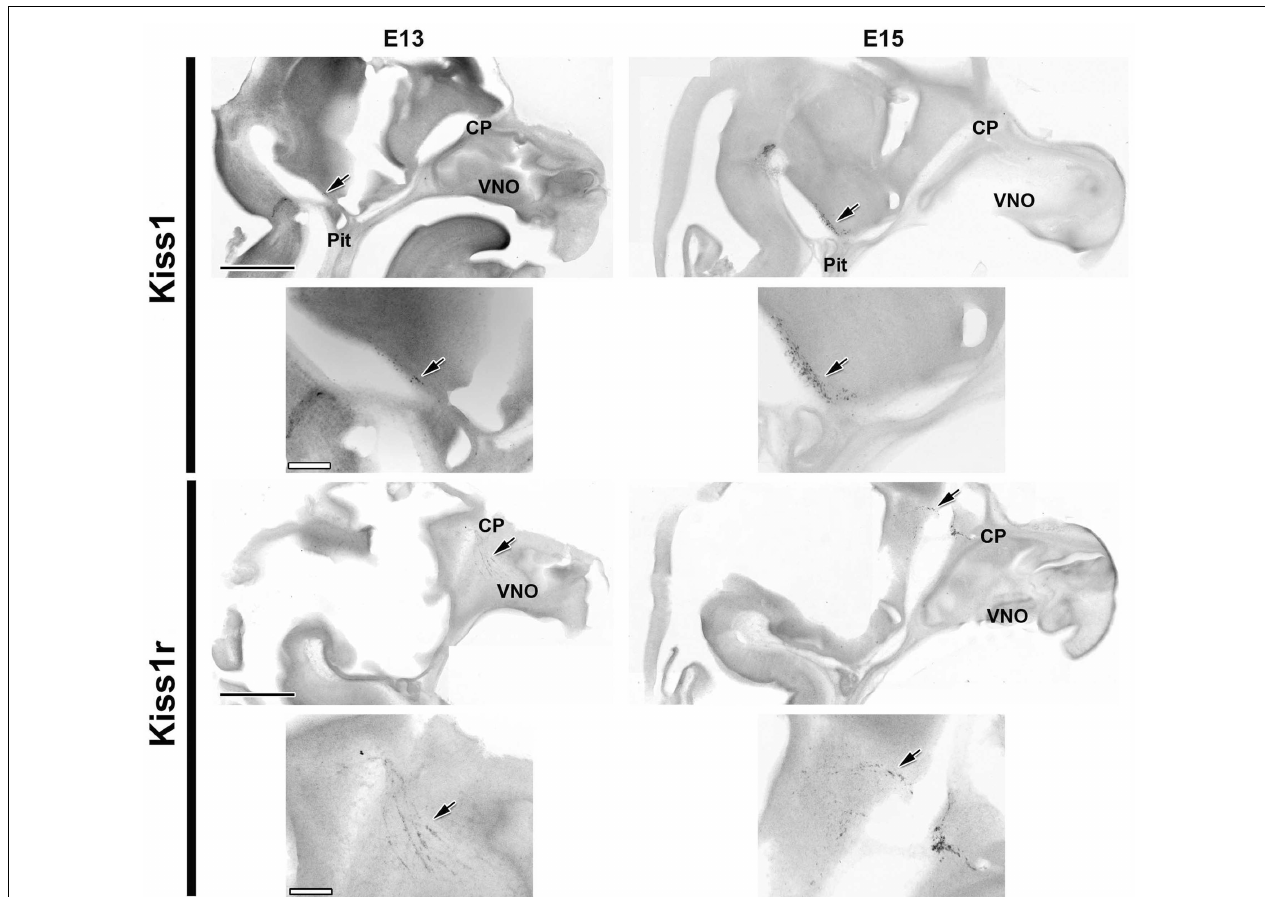
location of the Kiss1r positive cells from the nasal compartment to the forebrain between E13 and E15 reminiscent of the migrating GnRH neuron population. Arrows indicate the location of mRNA positive cells. CP, cribriform plate; Pit, pituitary;VNO, vomeronasal organ. Scale Bars: black = 1mm, white = 200 µ